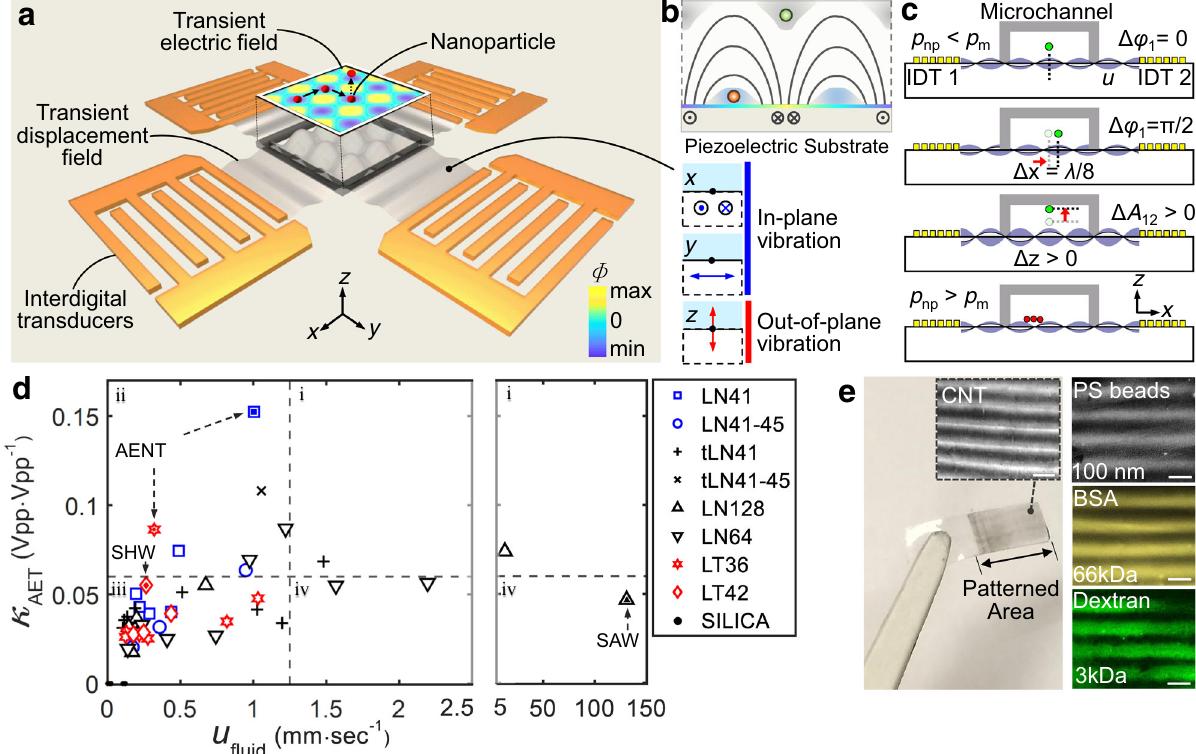
Fig. 1 Working principles of acoustoelectronic nanotweezers (AENT). a Acoustoelectronic fi elds are generated via dynamic acoustic wave interactions. These acoustic waves have minimal out-of-plane vibrations and associated acoustic attenuation losses in a fl uid. F is the surface electric potential. b Schematic side-view of the electric fi eld distribution and trapping positions for particles with different polarizabilities relative to the medium (red sphere: high polarizability; green sphere: low polarizability). c Schematic mechanism of AENT on manipulating nanoparticles with lower ( p np < p m ) or higher ( p np > p p olarizability than the medium in 3D space by tuning the phases and amplitudes of the acoustic waves. Δ φ m ) indicates the amplitudes variation of IDT 1 and IDT 2 . d Candidate excitation con fi gurations based on nine potential single-crystal piezoelectric materials for AENT. κ AET is the acoustoelectronic ef fi ciency, which is de fi ned as the ratio between the surface electric potential and the excitation voltage on the transducer in a standing wave mode. u fl uid is the acoustic streaming speed under consistent excitation amplitudes on different crystals. e Macroscopic materials with pre-designed nanotextures fabricated by AENT. Insets: microscopic images of PDMS fi lms containing aligned carbon nanotubes and 100 nm PS beads, PEG hydrogels containing textured FITC-BSA proteins (66 kDa) and FITC-dextran (3 kDa). Scale bar: 60 μ